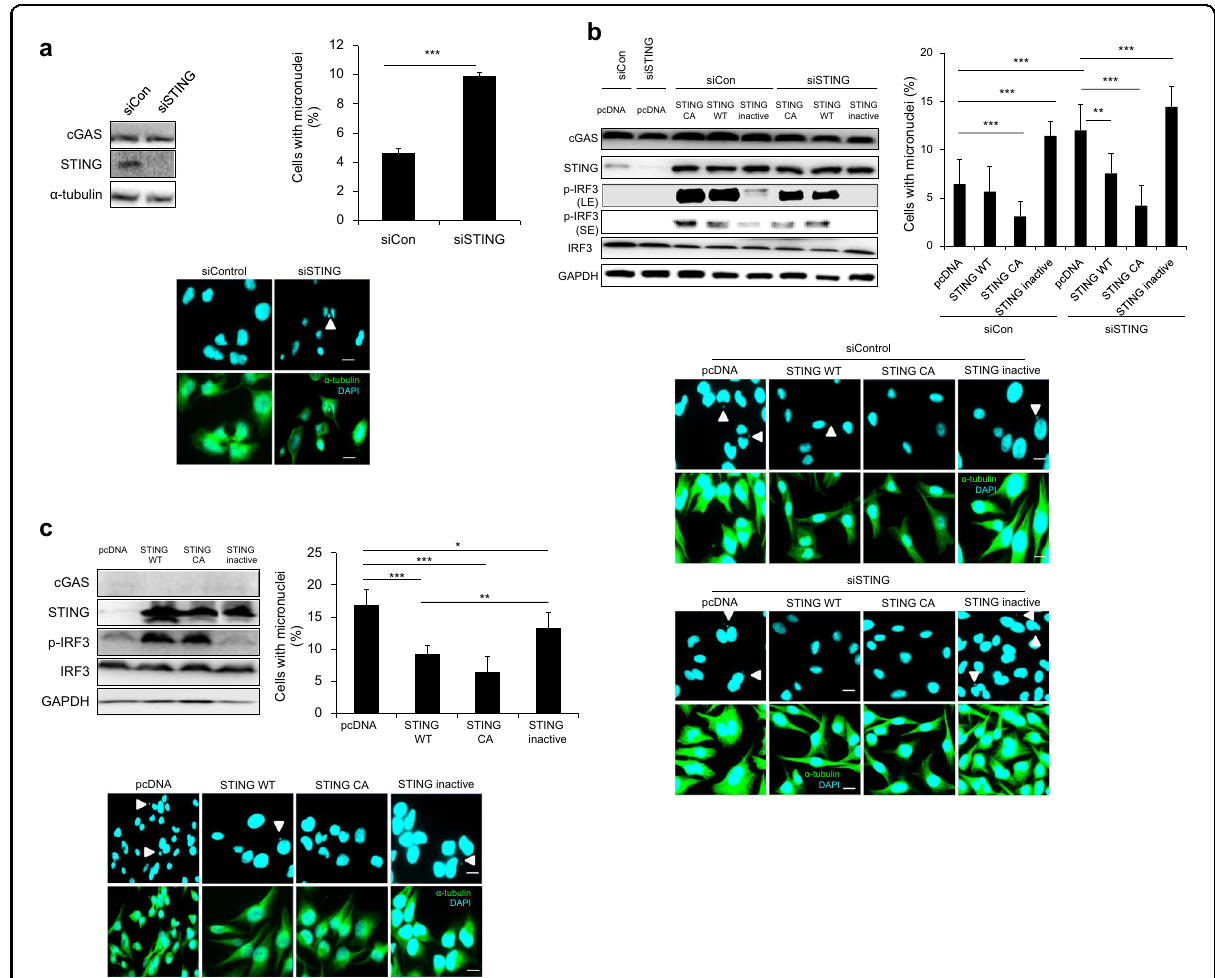
Fig. 4 STING activation via cGAS leads to chromosomal stability. a HeLa cells transfected with an siRNA targeting STING, and after 30 h they were treated with nocodazole for 16 h. Mitotic cells were subjected to western blotting (left panel) for cGAS, STING, and α -tubulin and to ICC (right panel) to analyze the percentage of micronucleated cells; representative fl uorescent images show micronuclei (white arrowhead denotes micronuclei). The results are given as the mean ± SD from three independent experiments ( n = 300). *** P < 0.001 as assessed by Student ’ s t -test. b HeLa cells were cotransfected with siSTING and different indicated plasmids for 20 h and then were arrested via nocodazole treatment. After 16 h, cells were released from arrest, and western blotting (left panel) with the indicated antibodies was performed. The percentages of cells with micronuclei were counted after performing ICC (right panel) on cells 10 h after their release from mitotic arrest; representative fl uorescent images show micronuclei (white arrowhead denotes micronuclei). The results are given as the mean ± SD from three independent experiments ( n = 300). *** P < 0.001 as assessed by Student ’ s t -test. c cGAS − / − HeLa cells were transfected with the indicated plasmids for 12 h before nocodazole treatment commenced for 16 h. Ten hours after release from mitotic arrest, cells were subjected to western blotting with the indicated antibodies and ICC to calculate the percentage of cells showing micronuclei formation after nocodazole release; representative fl uorescent images show micronuclei (white arrowhead denotes micronuclei). The results are given as the mean ± SD from three independent experiments ( n = 300). *** P < 0.001 as assessed by Student ’ s t